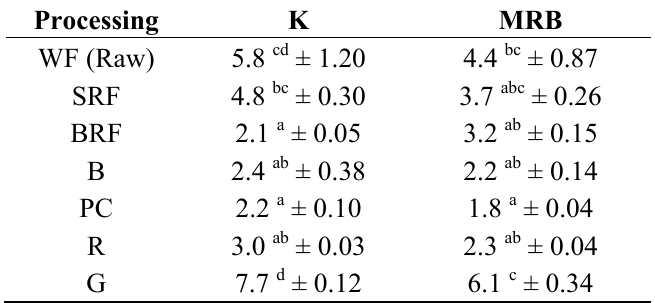
Table 1. Yield of methanolic extracts obtained from processed pearl millet